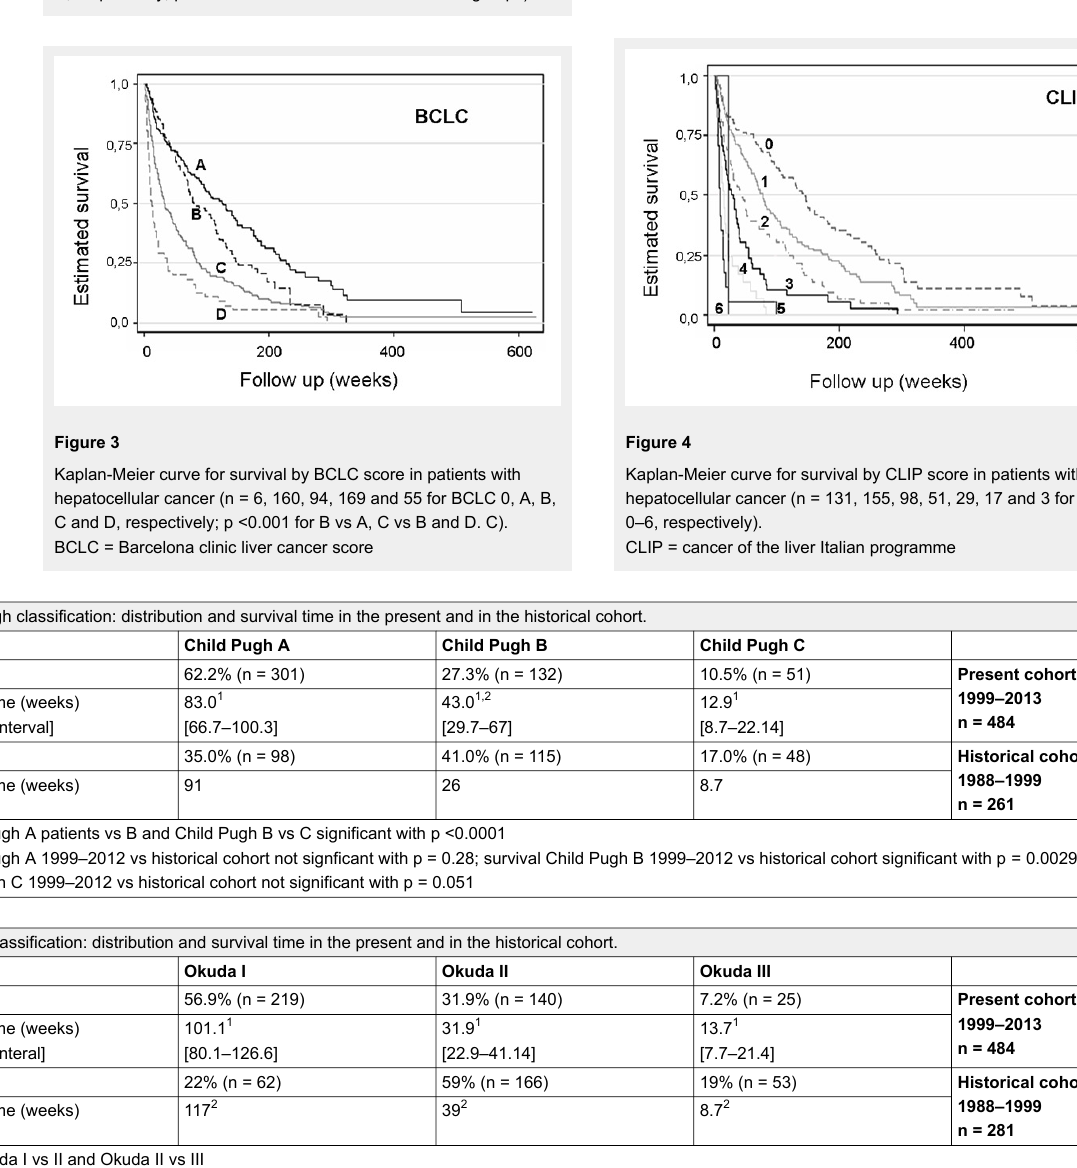
Kaplan-Meier curve for survival by Child Pugh score in patients with hepatocellular cancer (n = 301, 132 and 51 for Child Pugh A, B and C, respectively; p <0.001 for difference between the subgroups).